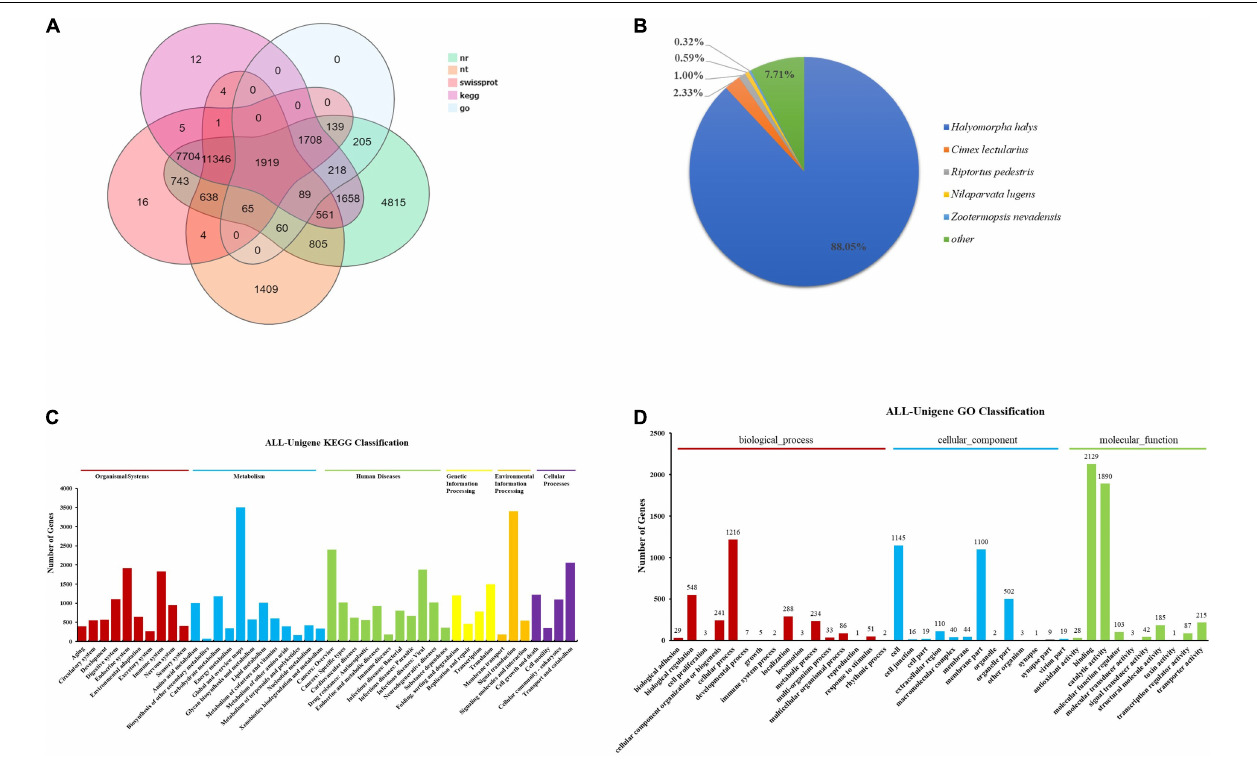
FIGURE 2 | Overall analysis of transcriptome data of T. papillosa . (A) Five gene function annotation database annotation results Venn diagram. (B) NR annotated species distribution. (C) The abscissa indicates the number of corresponding transcripts, and the ordinate indicates the functional classification of KEGG. (D) The abscissa indicates the number of corresponding transcripts, and the ordinate indicates the GO function classification.